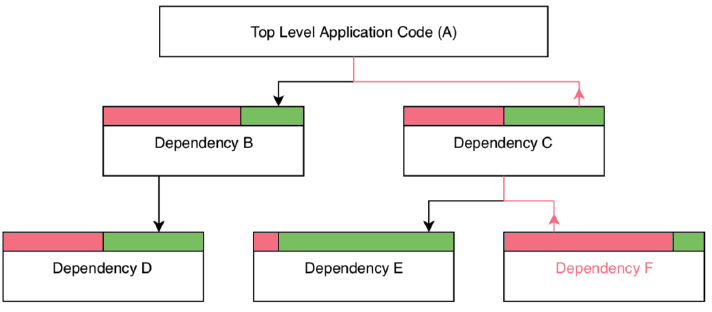
Figure 1. Nested dependencies.